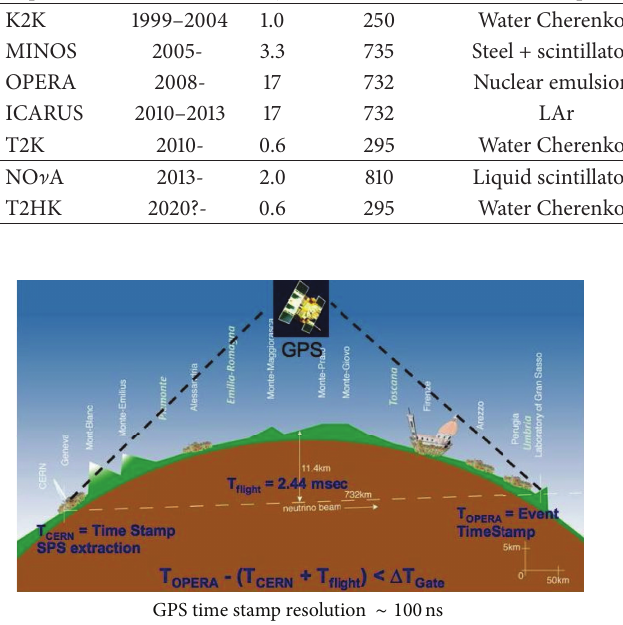
Figure 12: Sketch of the 730 km neutrino path from CERN to Gran Sasso and the GPS selection of events.